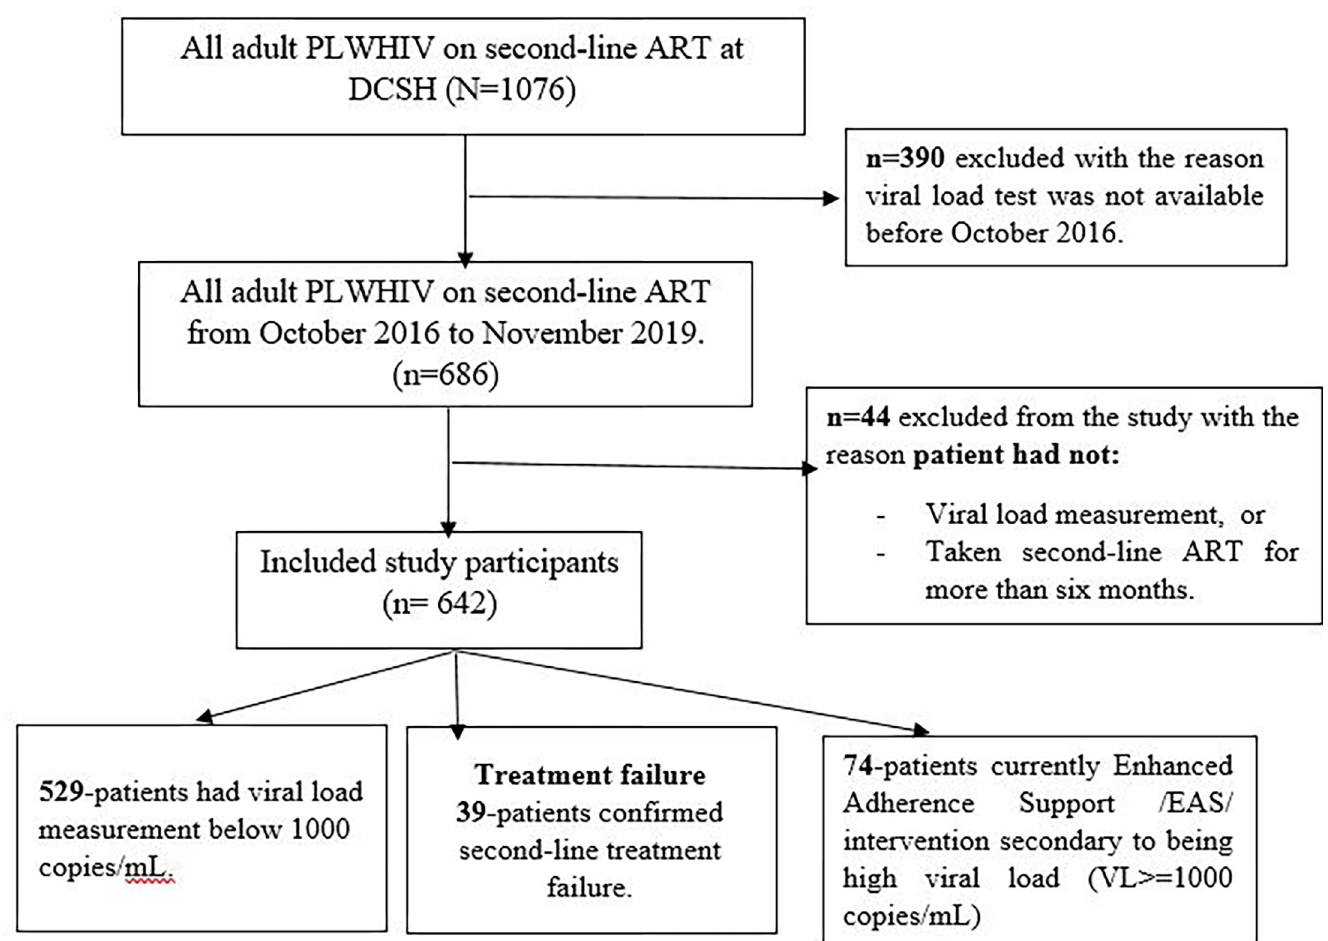
Fig 1. Second-line treatment failure among PLWHIV on second-line therapy at Dessie Comprehensive Specialized Hospital/DCSH/, northeast Ethiopia, from October 2016 to November 2019. (n = 642).